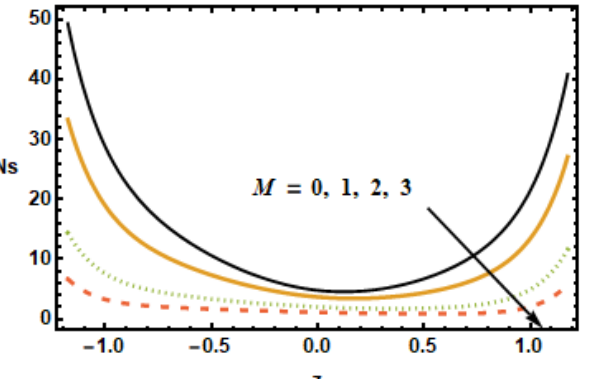
Figure 19. Effects of Hartman number M on Ns . Figure 20. Effects of Hall parameter